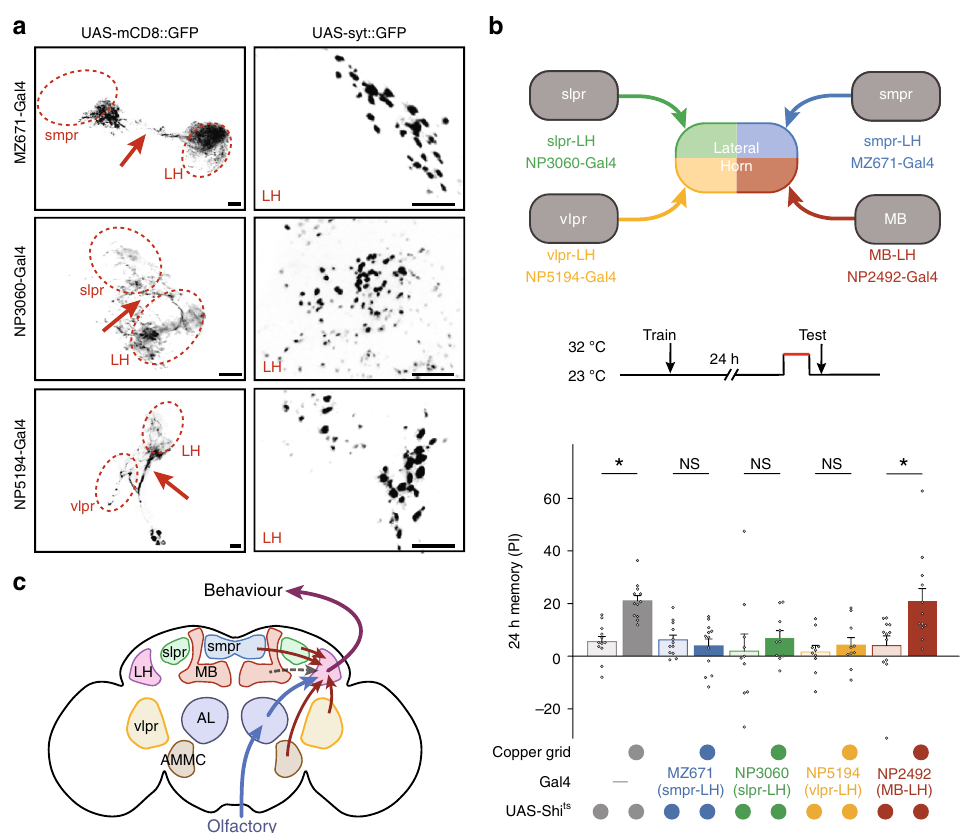
Fig. 5 Retrieval of cLTM requires neurons connecting the LH with other regions. a Left: NP1004-Gal4, MZ671-Gal4, NP3060-Gal4, and NP5194-Gal4. Neurons connecting the superior medial protocerebrum, superior lateral protocerebrum, and ventral lateral protocerebrum with the LH are broadly labelled (arrows). Right: The presynaptic marker syt::GFP in these LH neurons is highly concentrated in the LH region. Scale bar = 20 μ m. b Top: protocol. Middle: Schematics of MZ671-Gal4, NP3060-Gal4, NP5194-Gal4, and NP2492-Gal4, that labels neurons connecting the smpr, slpr, vlpr, and mushroom body (MB) with the LH. Bottom: Blockade of any of these LH neurons during retrieval abolishes context-dependent long-term memory (cLTM), but MB-V2 (connecting the MB to the LH) is dispensable during cLTM retrieval ( n = 10 – 12). c Schematic of the brain showing a model of cLTM retrieval mediated by multiple information integration. Grey-dashed arrows denote that information from the MB is not required. Data are mean performance indices ± SEM; individual data points are displayed as dots; * P < 0.05 by ANOVA or t